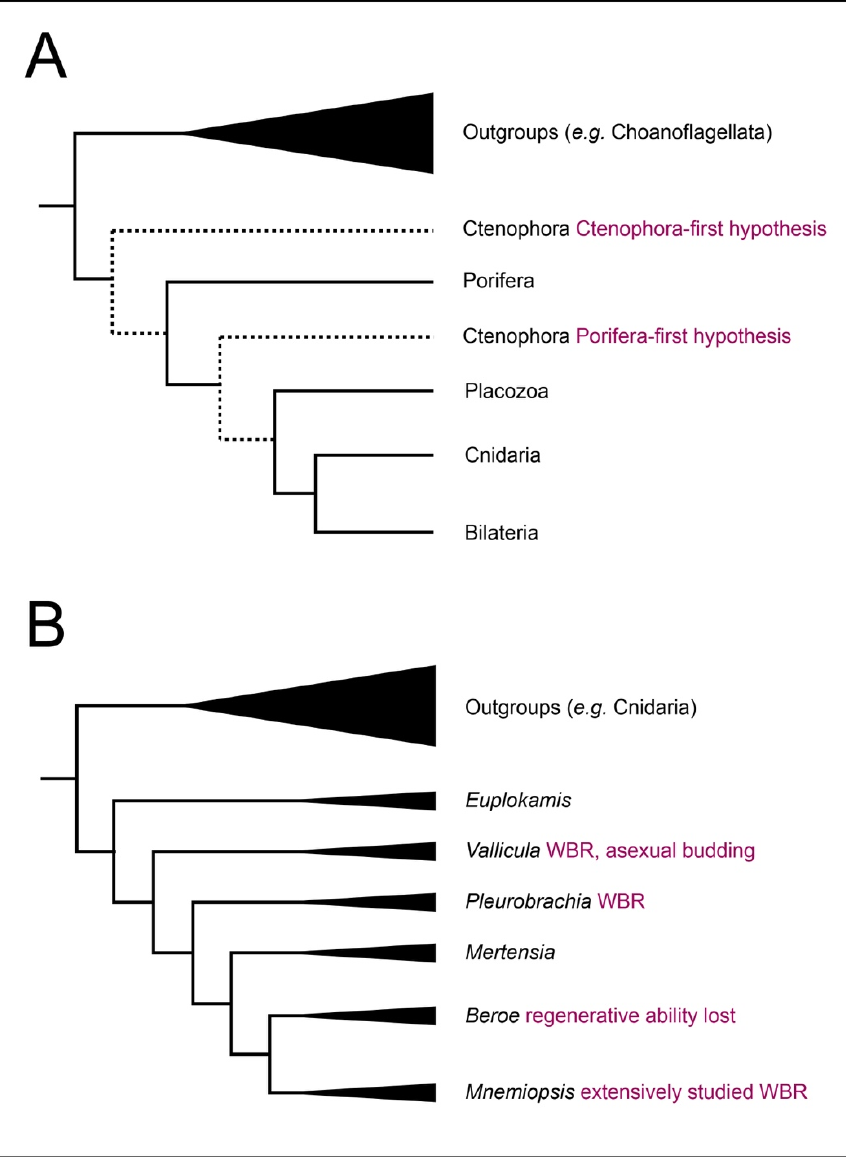
Figure 1. Evolutionary relationships of ctenophores. Topology drawn from [7]. ( A ) Relationships of metazoans. Ctenophores are the sister to all other metazoan taxa. ( B ) Evolutionary relationships among selected ctenophore genera; branch tip labels include genera referred to in this manuscript and its cited sources. Note that revision of traditional orders has been strongly suggested by most recent reconstruction, and position of Mertensia is not fully resolved.